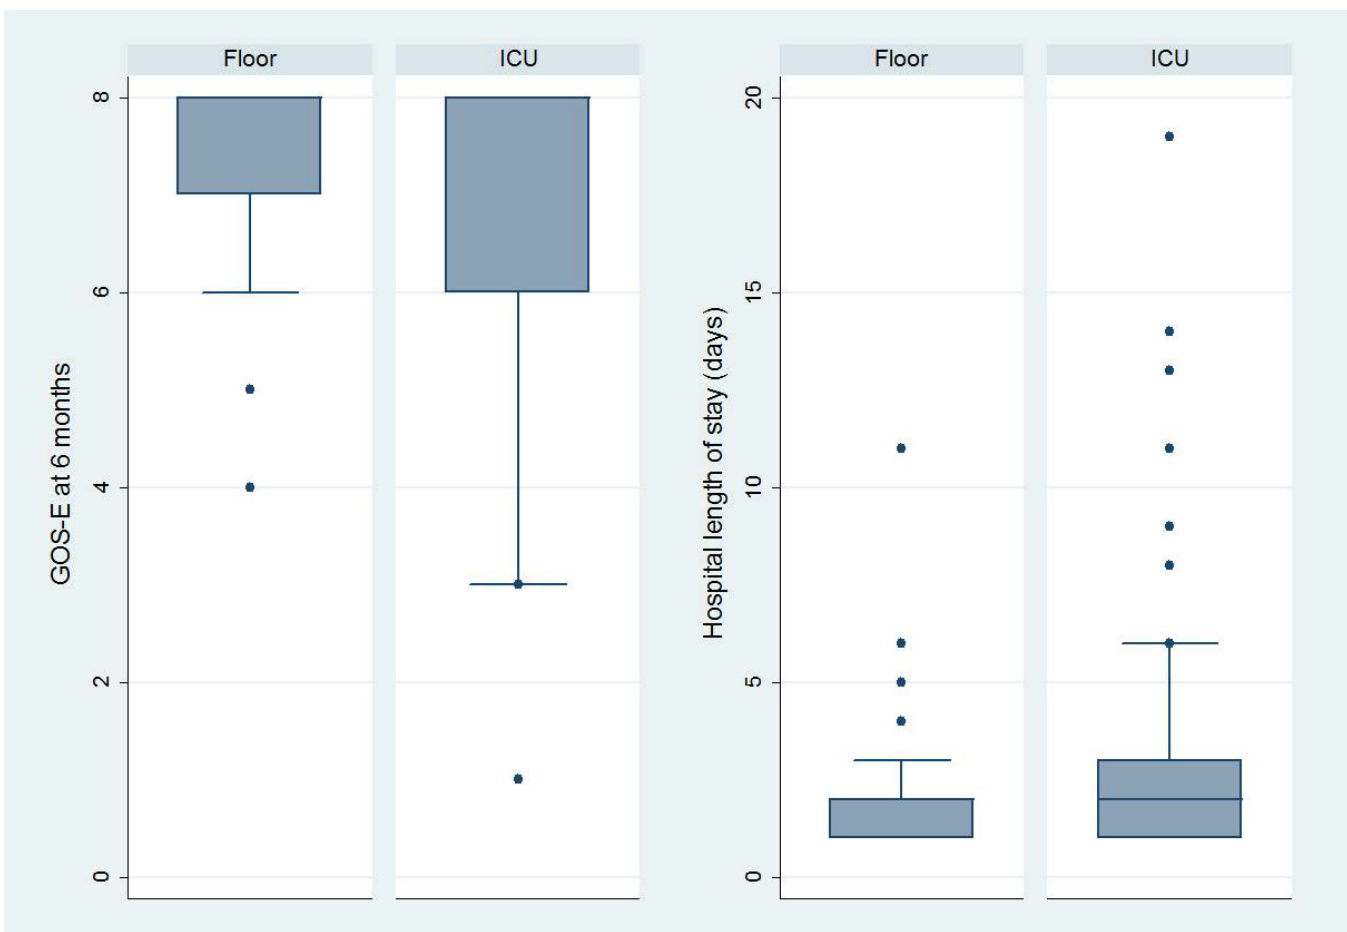
Figure 3. Distribution of outcome measures by admission location. GOS-E , extended Glassgow Outcome Score; ICU , intensive care unit